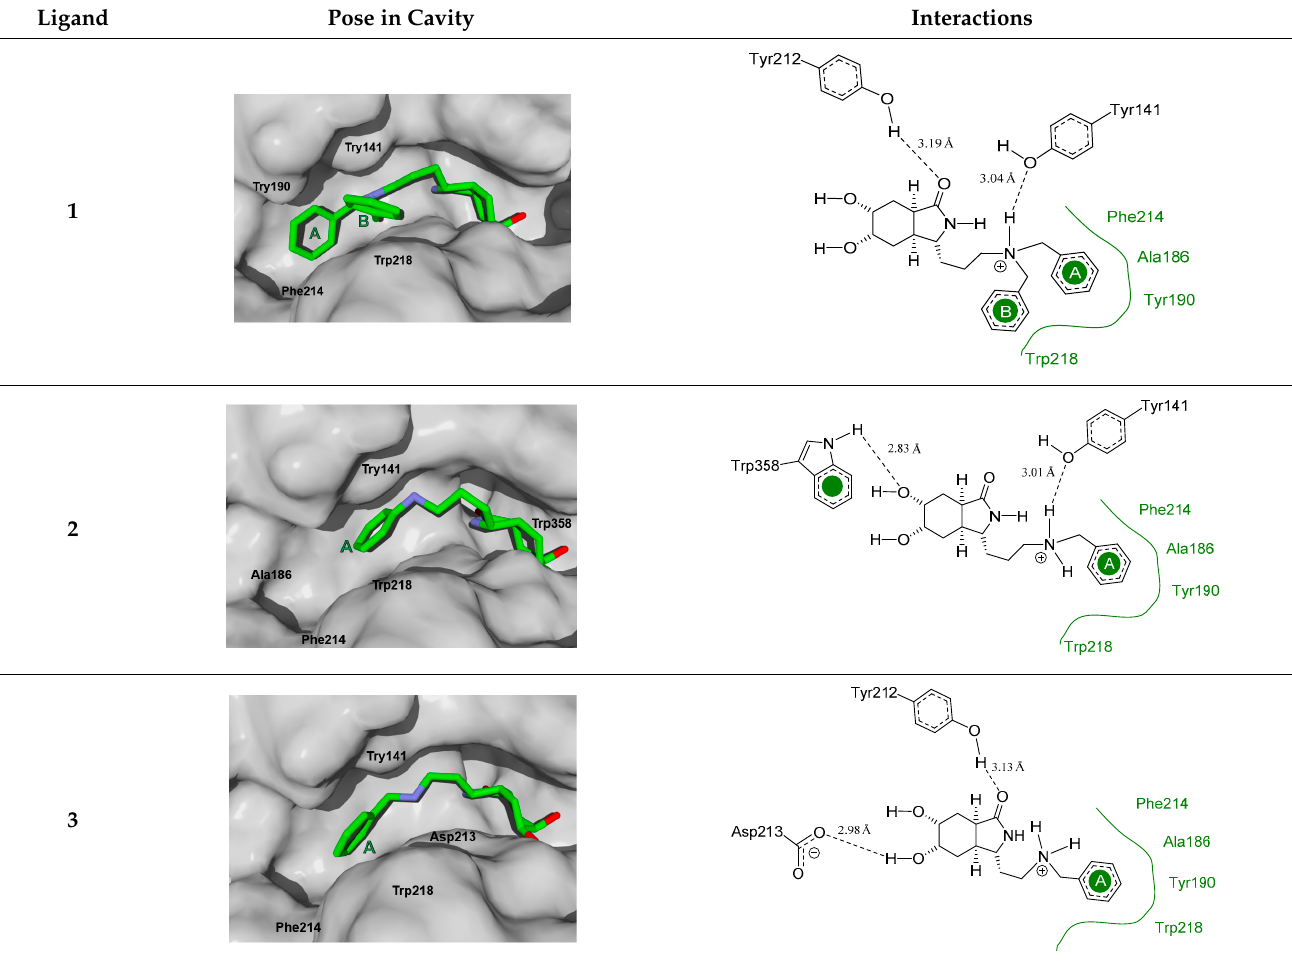
Table 2. Best pose of scaffold derivatives (ligands) in Homo sapiens CHIT1. Ligand Pose in Cavity